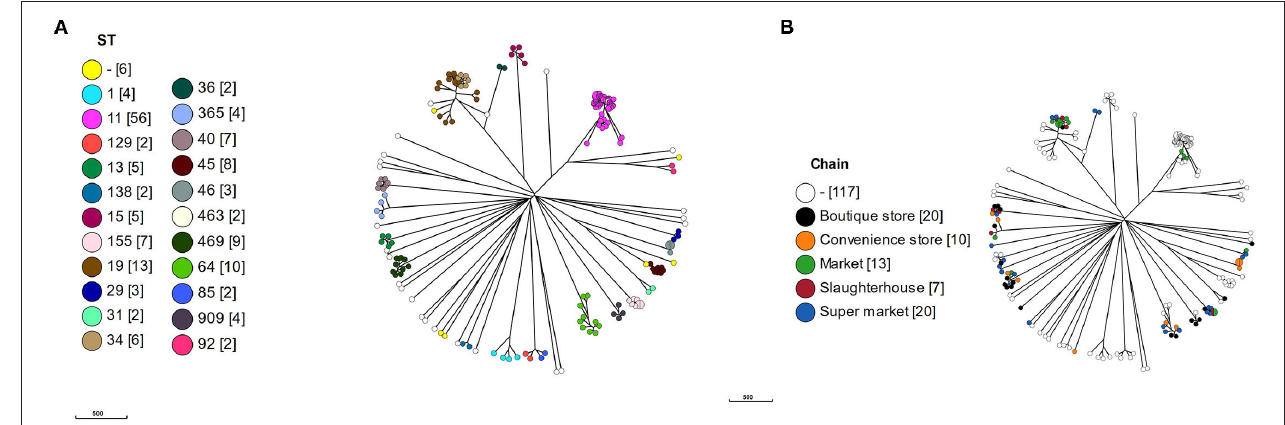
FIGURE 2 | A minimal spanning tree based on core genome multi-locus sequencing type (cgMLST). A cgMLST schema was produced using a chewBBACA salmonella predetermined schema. The schema was used to call alleles in 117 reference and 69 Vietnamese isolates and a MSTree produced. (A) MSTree colored by MLST sequence type (ST) with number of isolates in square brackets, (B) MSTree colored by value chain location of